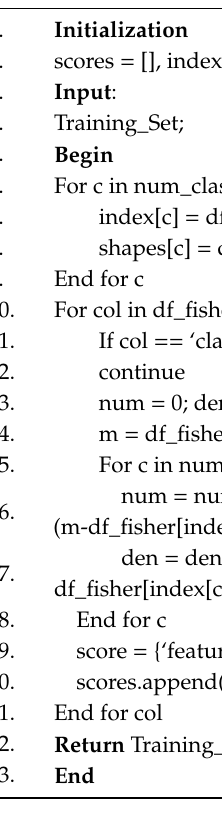
Algorithm 1. Pseudocode of Fisher score